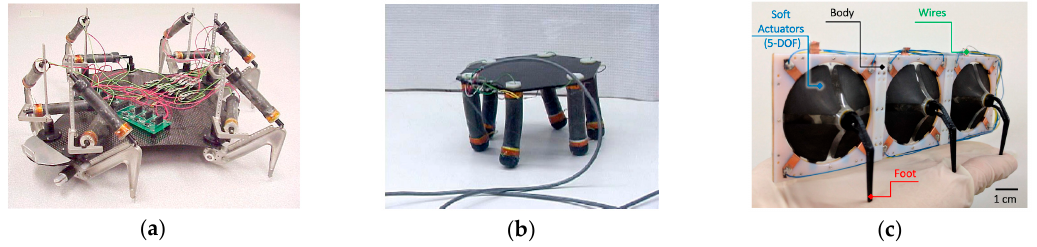
Figure 9. Insect-like waling robots which are driven by DEAs: ( a ) FLEX2 [8]; ( b ) MERbot [80]; ( c ) S- Hex2